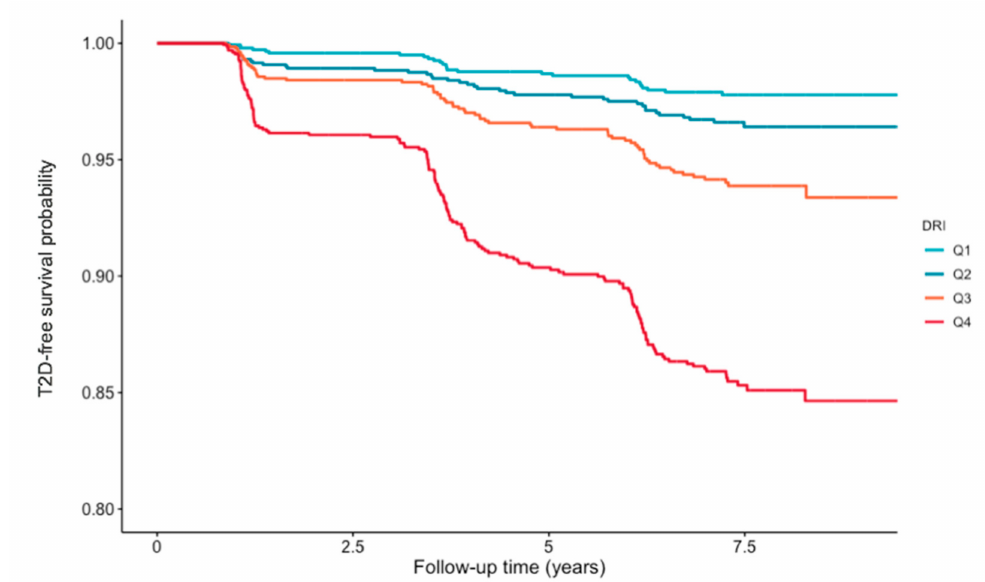
Figure 1. Kaplan–Meier survival curves for time to T2D diagnosis according to sex-stratified quartiles of DRI, by log-rank test ( p <